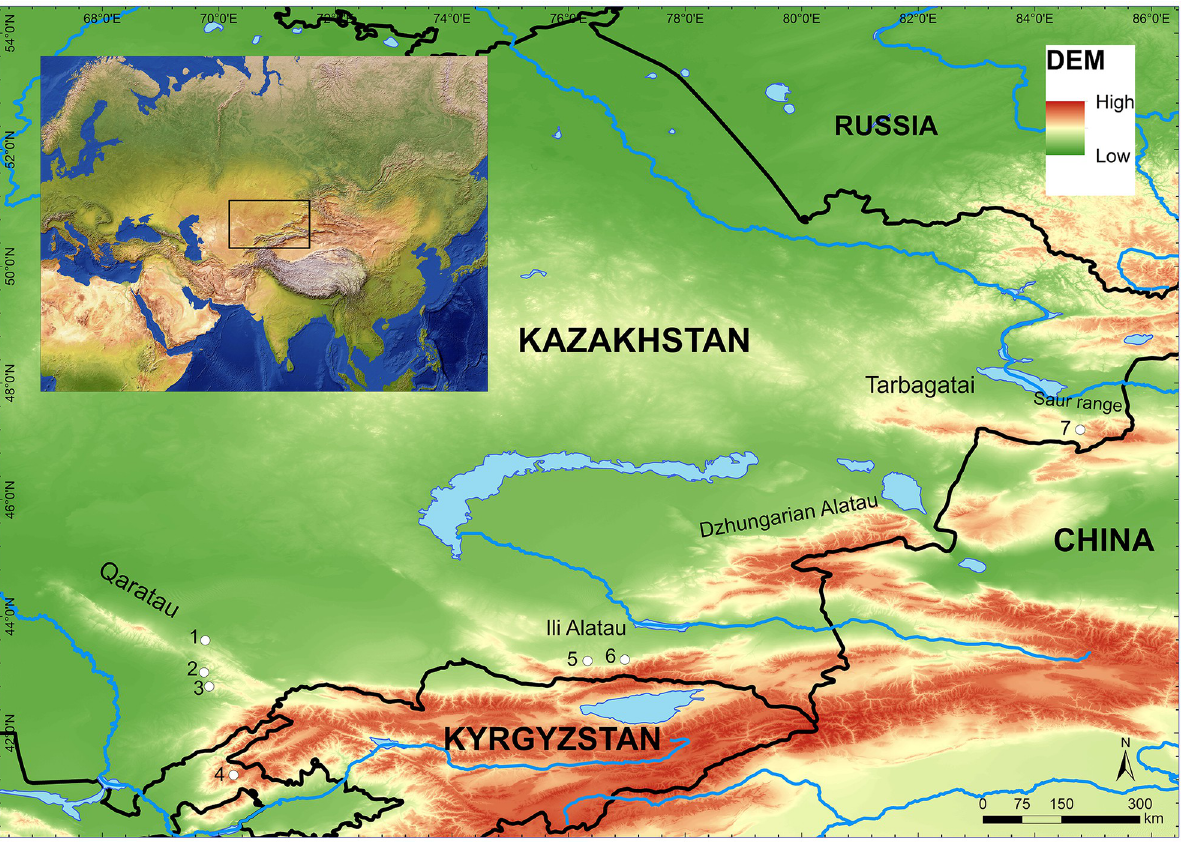
Fig 1. Palaeolithic sites mentioned in the text and illustrated in relation to the major topography of the Inner Asian Mountain Corridor (Kazakh portion). 1) Yntaly, 2) Usiktas (surface site), 3) Valikhanova, 4) Kattasai, Uzbekistan, 5) Maibulaq, 6) Rahat, 7) Ushbulaq. Data sources: Global Administrative areas (GADM) [59], vector and raster map data from Natural Earth (www.naturalearthdata.com) and Shuttle Radar Topography Mission (SRTM) Version 4